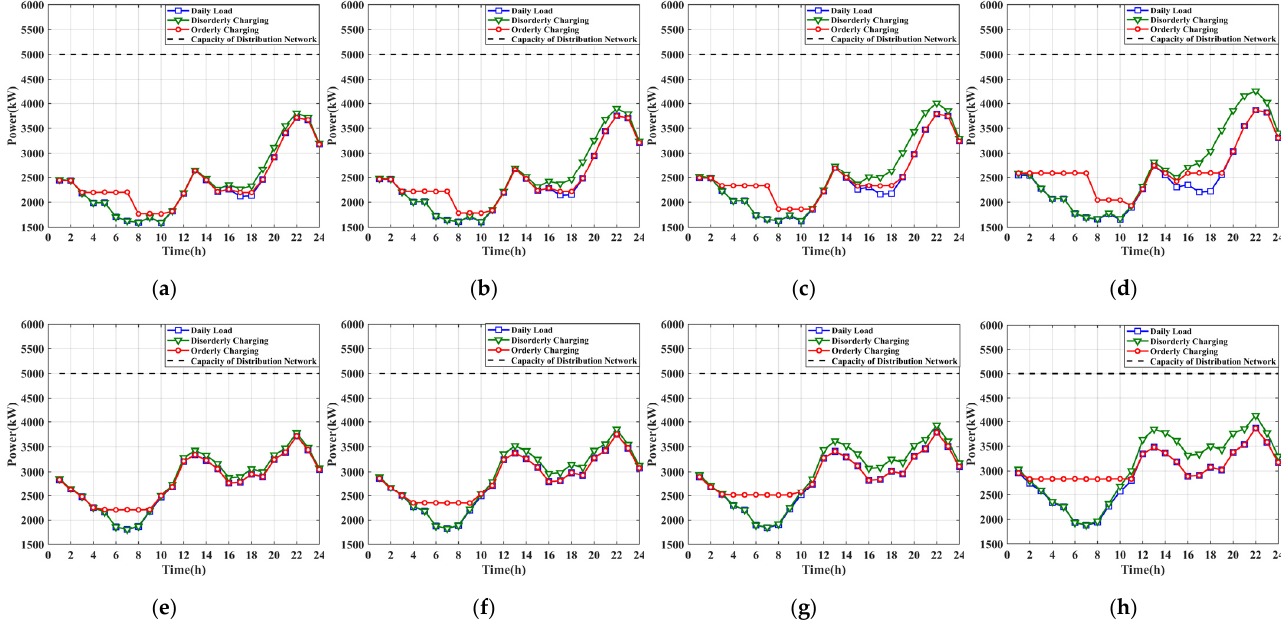
Figure 4. Orderly charging planning results: ( a ) 2021 (weekday), ( b ) 2022 (weekday), ( c ) 2023 (weekday), ( d ) 2025 (weekday), ( e ) 2021 (weekend), ( f ) 2022 (weekend), ( g ) 2023 (weekend), ( h ) 2025 (weekend).